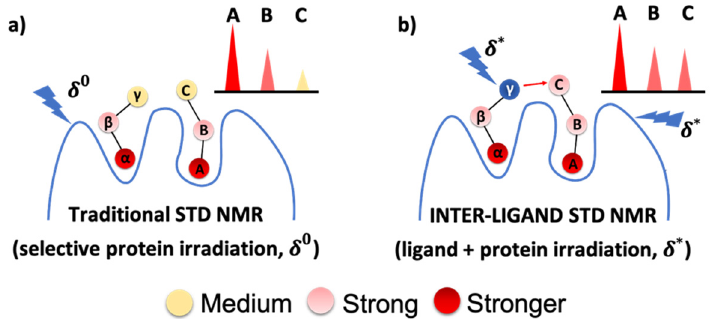
Figure 1. Cartoon representing the IL-STD NMR approach. ( a ) STD NMR with selective irradiation ( δ 0 ) on protein protons. ( b ) STD NMR with selective irradiation ( δ ∗ ) on “ reporter ligand ” proton γ (supposed to be close to proton C of the adjacent “ ligand of interest ”) as well as on protein protons. The analysis of the IL-STD NMR experiment is focused exclusively on the protons of the ligand of interest ( A , B , C in the cartoon). Significant differences in binding epitope mapping on the ligand of interest will indicate proximity between both ligands.